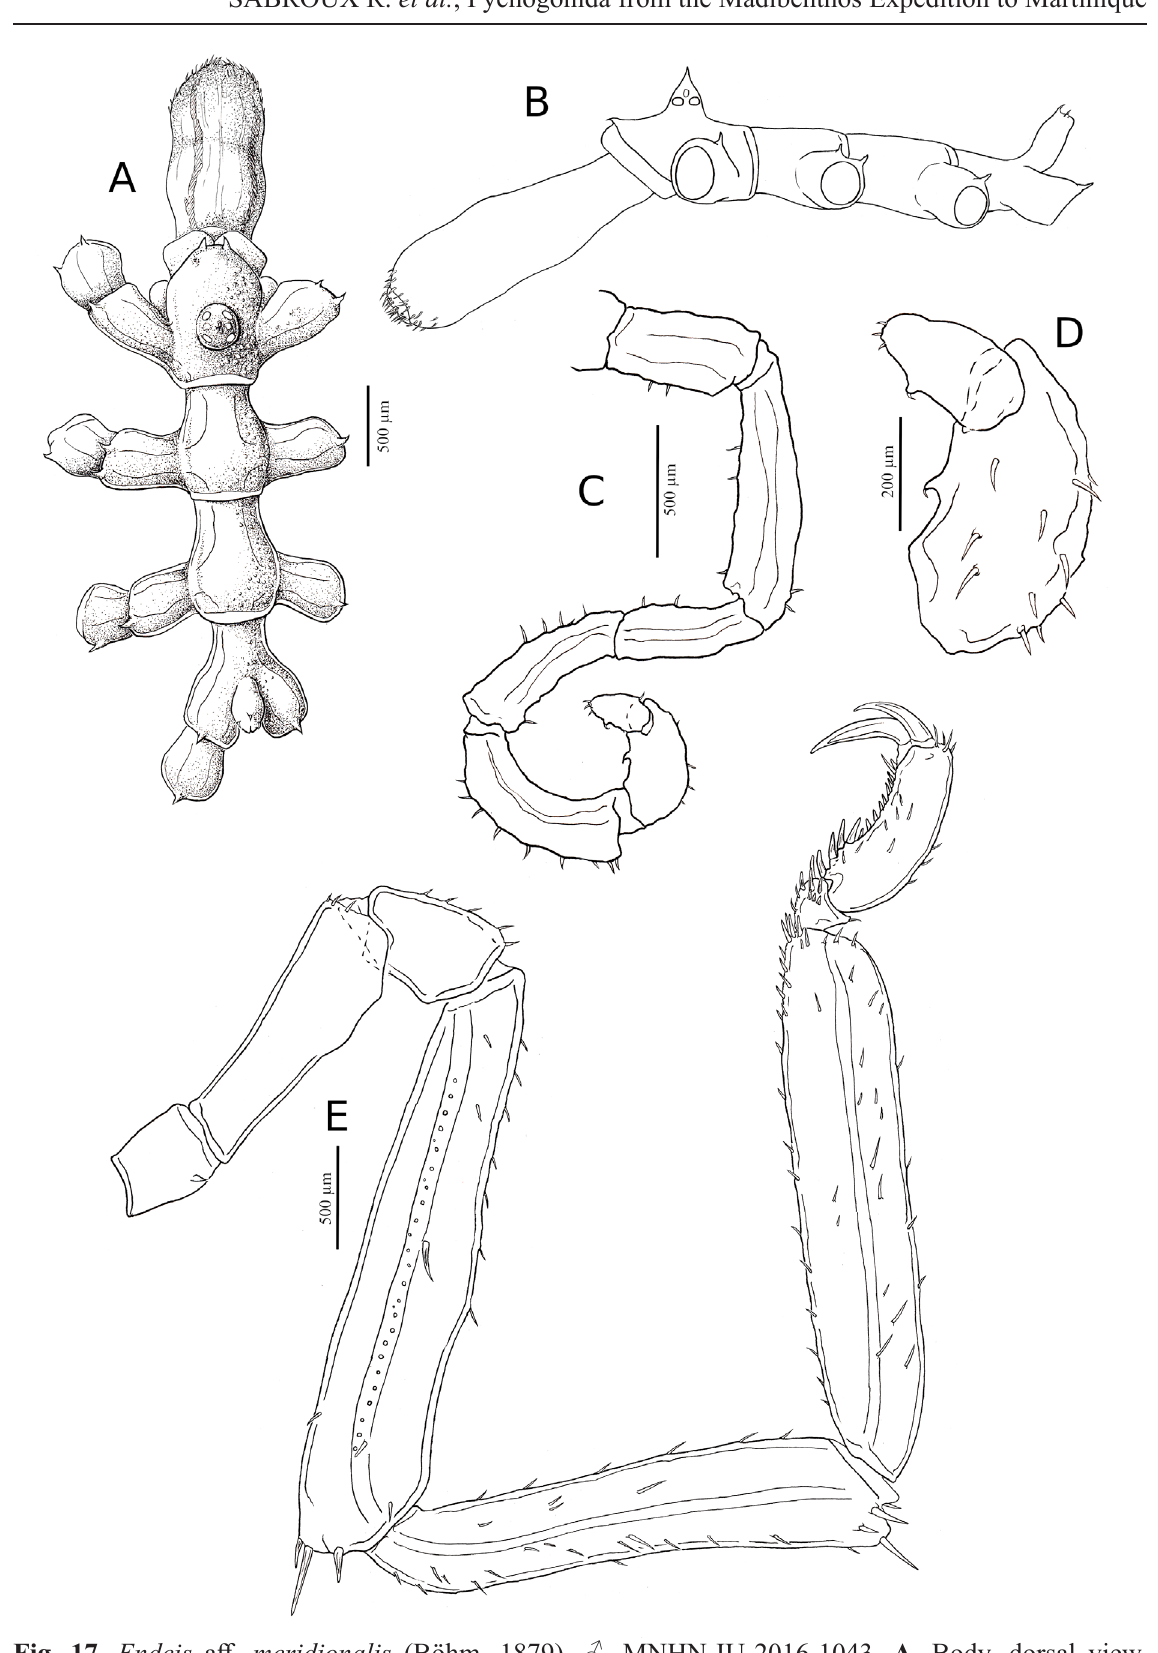
Fig. 17. Endeis aff. meridionalis (Böhm, 1879), ♂, MNHN-IU-2016-1043. A . Body, dorsal view. B . Body, lateral view (same scale as A). C . Oviger. D . Last two oviger articles. E . Third